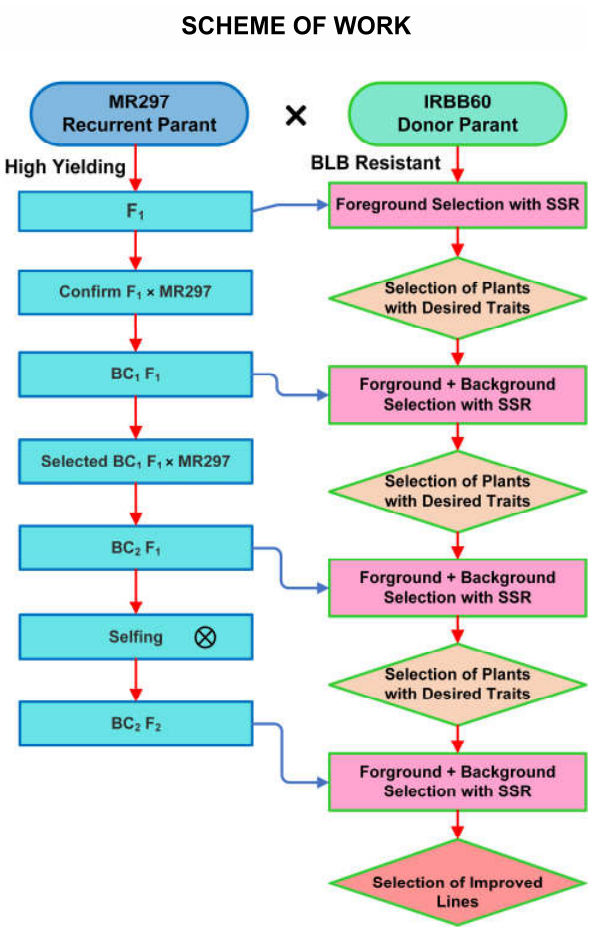
Figure 1. A schematic showing how marker-assisted backcross breeding was used to create high- yielding, BLB-resistant rice varieties (MABB).